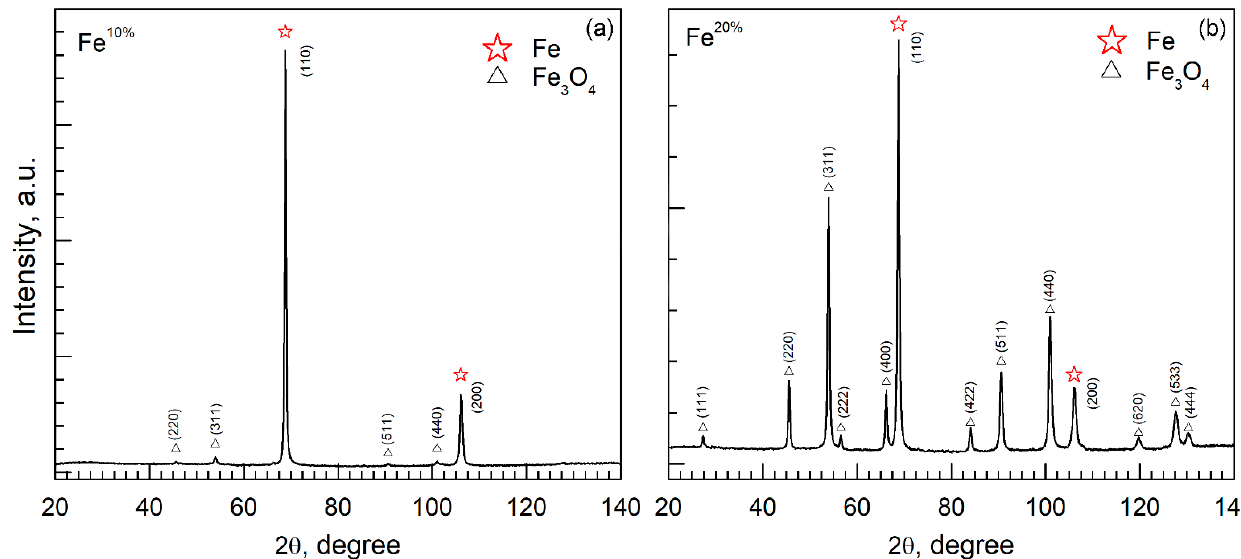
Figure 1. X-ray diffraction measured from the ( a ) Fe 10% and ( b ) Fe 20% samples. Table 1. XRD data, where a —lattice constant, CS—crystallite size, ω Fe and ω oxide —mass fraction of iron and Fe 3 O 4 oxide in each sample, calculated by means of the RIR method, Ms —saturation mag- netization, Hc —coercivity.